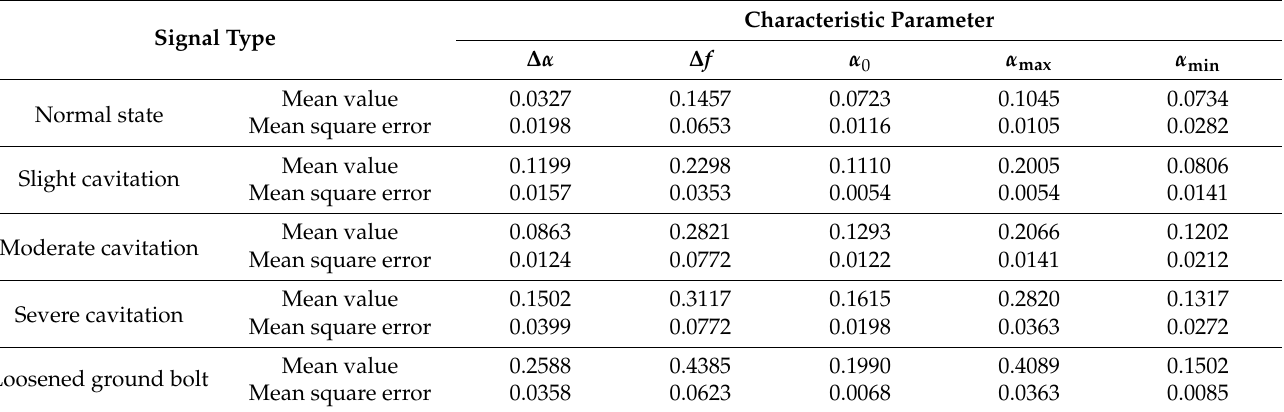
Table 3. Statistical data of the characteristic parameters of the centrifugal pump vibration